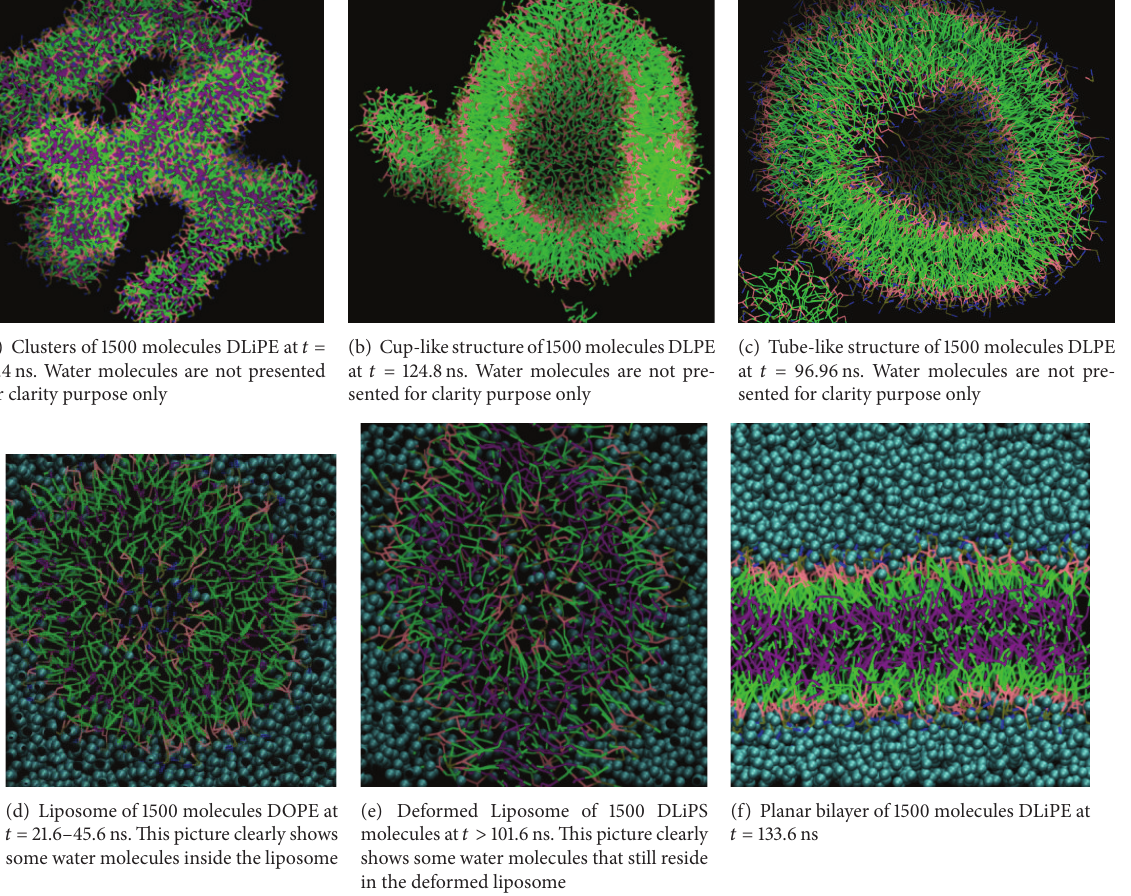
Figure 3: Various aggregate structures of phospholipid molecules during 160 ns simulation time. Bead of atoms in phospholipid molecules are represented by colored lines. Phospholipid head groups are green or blue lines, brown for phosphate, glycerol backbone pink and green hydrocarbon tail groups, and purple for the double bonds in the tail groups. Water molecules are presented by light blue beads.